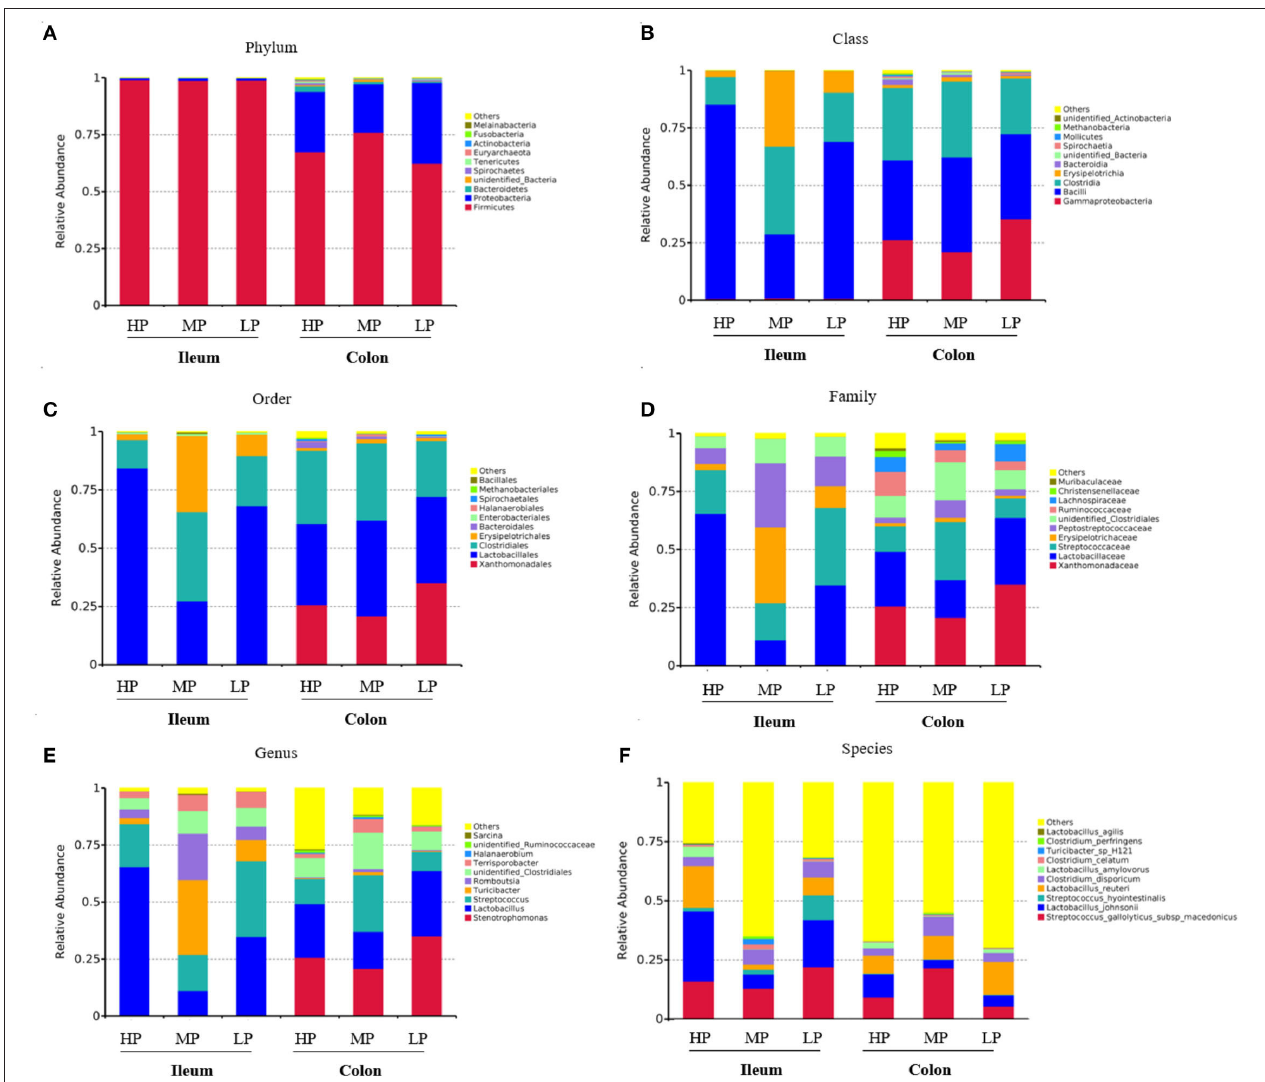
FIGURE 3 | Effect of low-protein diet on the composition of gut microbiota at different taxa levels in finishing pigs. (A) Phylum, (B) class, (C) order, (D) family, (E) genus, and (F) species. HP, high protein (16% crude protein); MP, medium protein (12% crude protein); LP, low protein (10% crude protein).